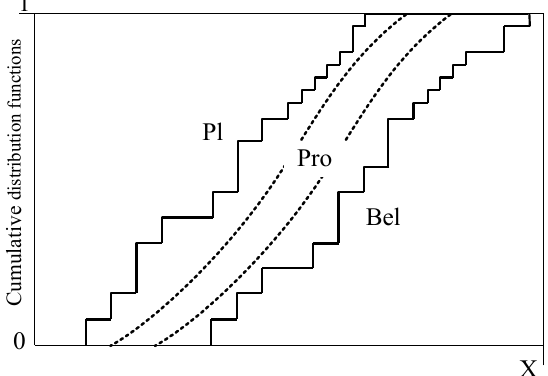
Figure 2.Upper bound (Pl) and lower bound (Bel) on probability